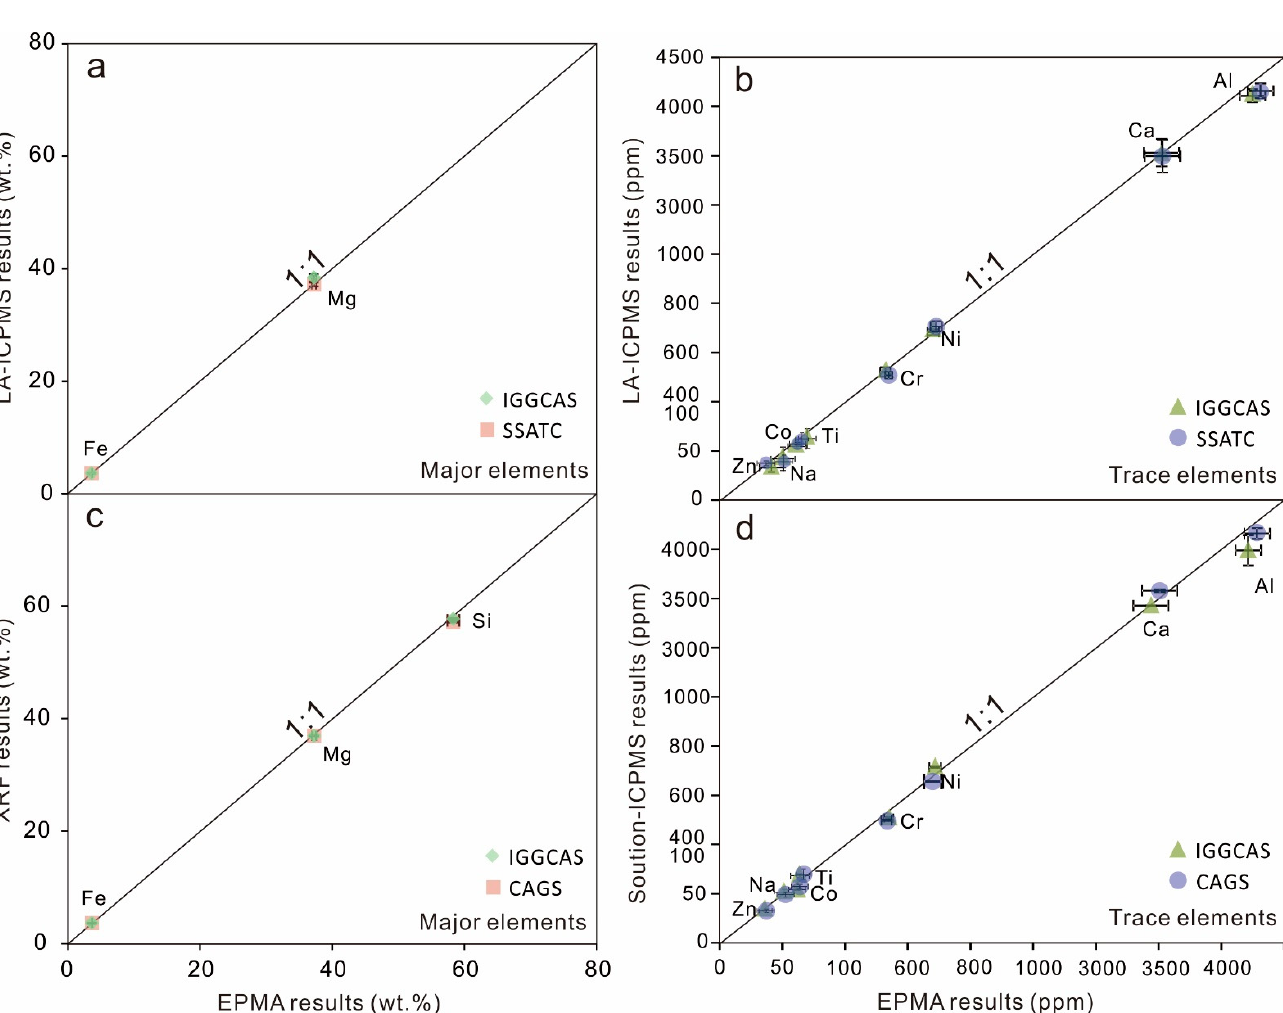
Figure 6. Comparison of major and trace element abundances determined by EPMA, LA-ICPMS, XRF, and solution-ICPMS techniques. A 1:1 line is drawn in each plot for comparison purposes. EPMA data show outstanding agreements with XRF and LA-ICPMS results obtained by different laboratories with RSE < ±2% for major elements ( a , c ) and with RSE< ±10% for trace elements ( b , d ).